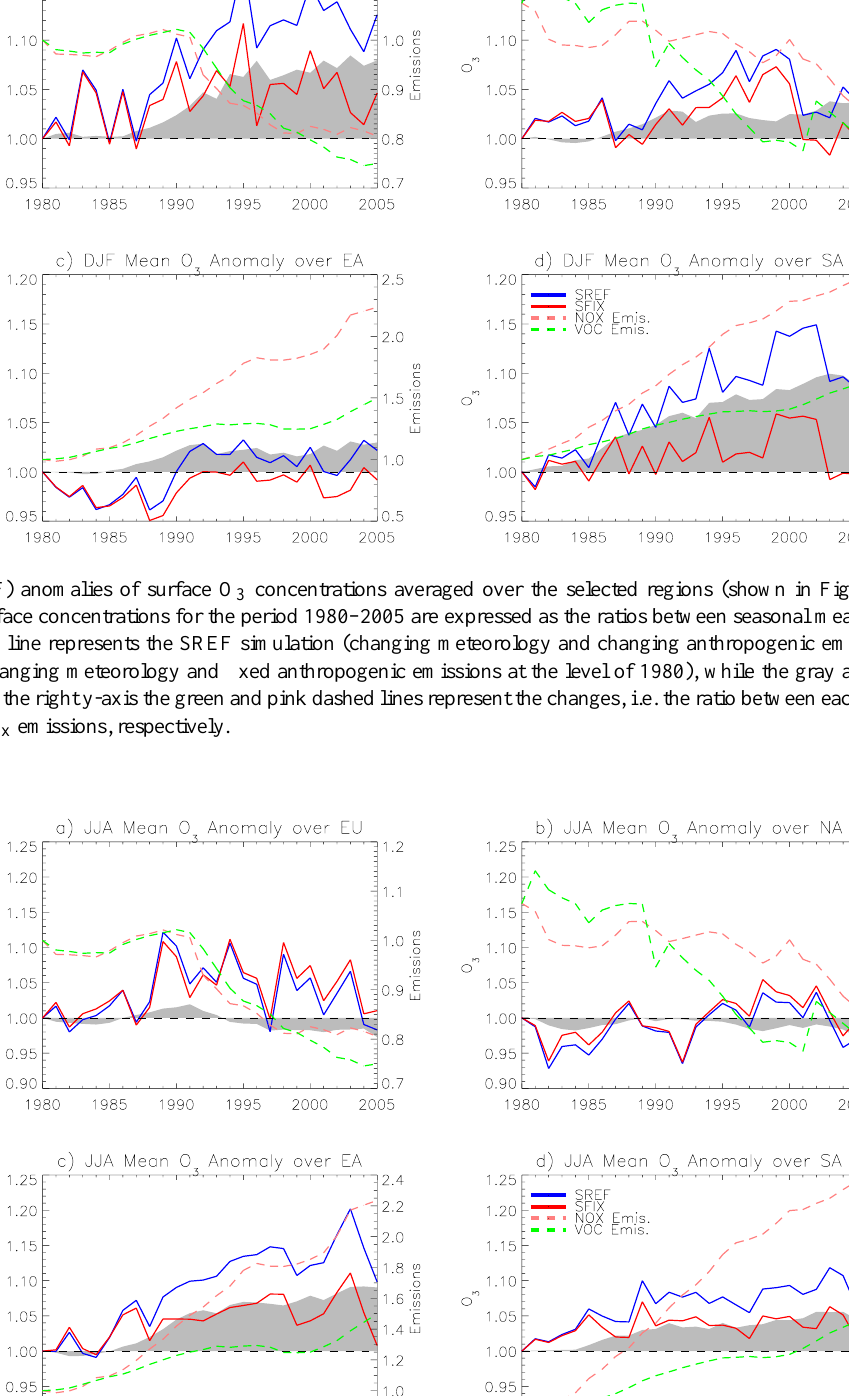
Atmos. Chem. Phys., 11, 9563–9594, 2011